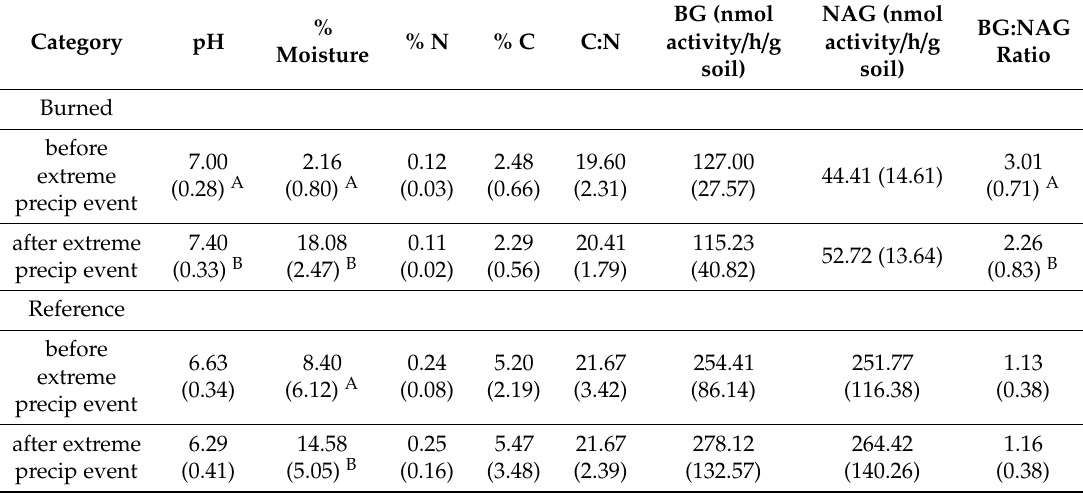
Table 1. Edaphic property and enzyme activity means and standard deviation for both burned and reference forest soils, before and after extreme precipitation event. Letters denote significant di ff erences as per Tukey’s HSD (All variables, except soil moisture) and Kruskal-Wallis contrasts (only soil moisture) to test di ff erences before and